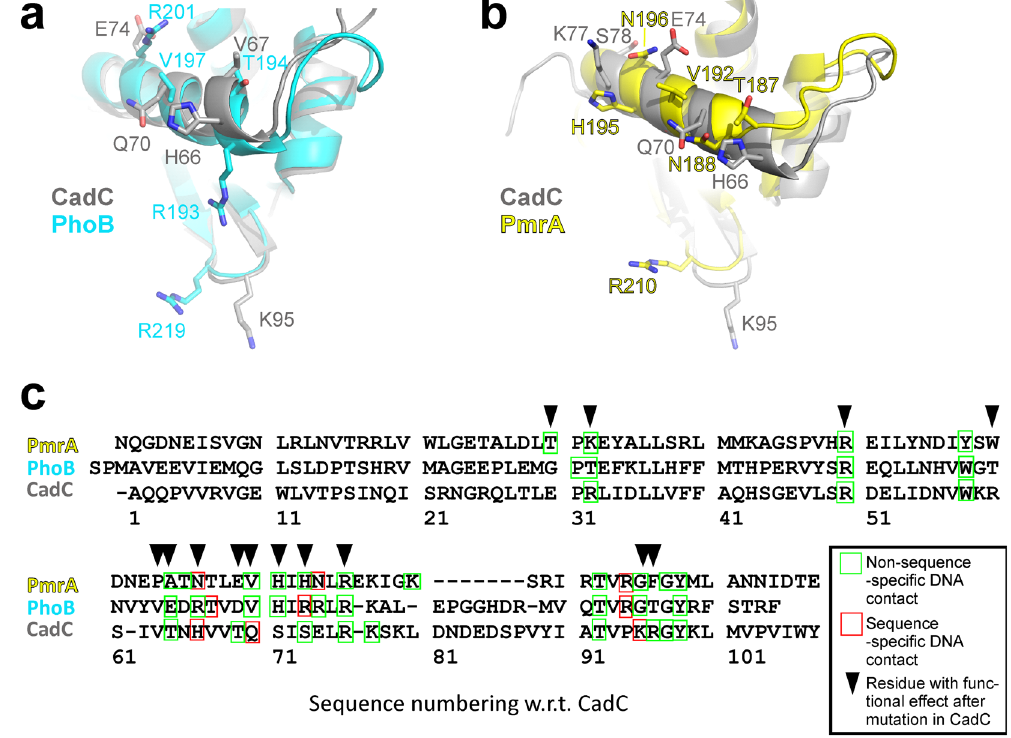
Figure 8. Structural comparison of DBD - DNA complexes. ( a ) Superposition of CadC 1-107 and PhoB 16 as taken from their complex structures. Shown is the recognition helix and the β -wing with analogous residues that are involved in specific interactions with DNA in at least one of the complex structures/model. Residues were selected from the structure-based alignment shown in ( c ). ( b ) The same as in ( a ) but with PmrA as taken from its complex structure with DNA 18 . ( c ) Structure-based sequence alignment of the CadC DBD and the DBDs from PhoB and PmrA with residues contacting DNA as indicated. Arrows above the sequence show residues with a functional impact after mutation in CadC (see Fig.